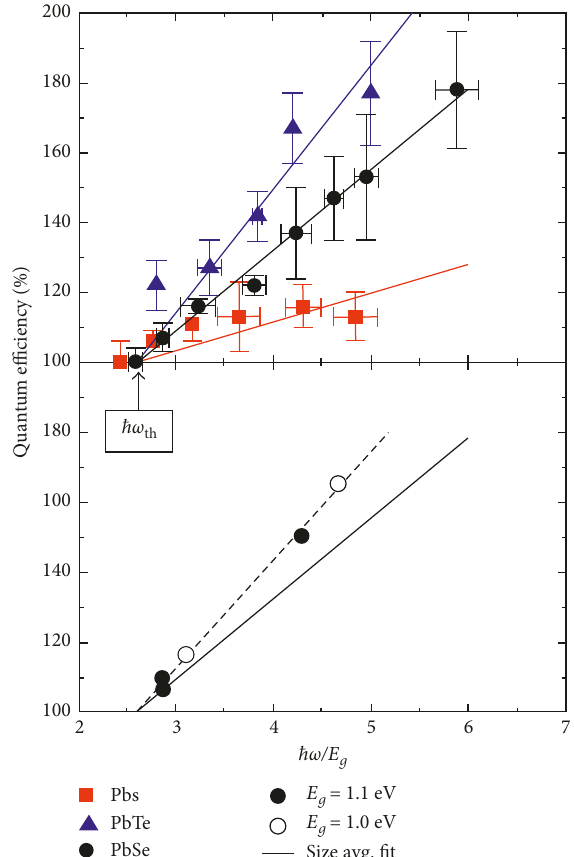
Figure 4: An example of MEG for the three most studied PbX QDs as a function of standardised pump energy, (cid:31) hω /E g . In (a), sig- nificantly different QYs, indicative of different ε eh for each QD, can be seen, adapted from